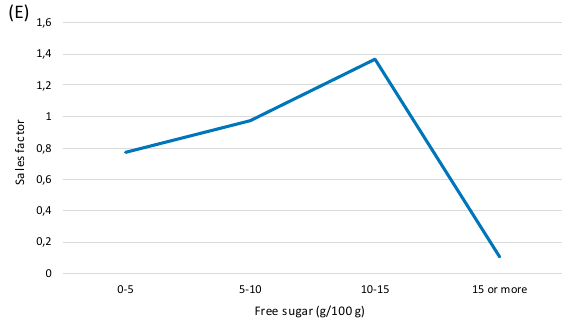
Figure 5. The correlation of the free sugar content and sales. ( A ) Yogurts; ( B ) Biscuits; ( C ) Breakfast cereals; ( D ) Cakes, muffins and pastry; and ( E ) Soft drinks.